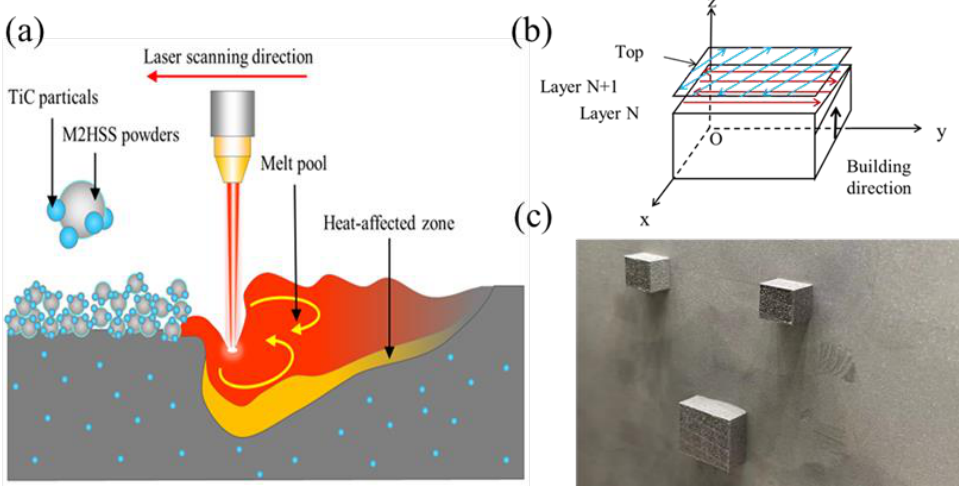
Figure 2. Schematic ( a ) diagram of LPBF TiC/M2HSS composite processing; ( b ) laser scanning strategy; ( c ) TiC/M2HSS samples printed by LPBF.